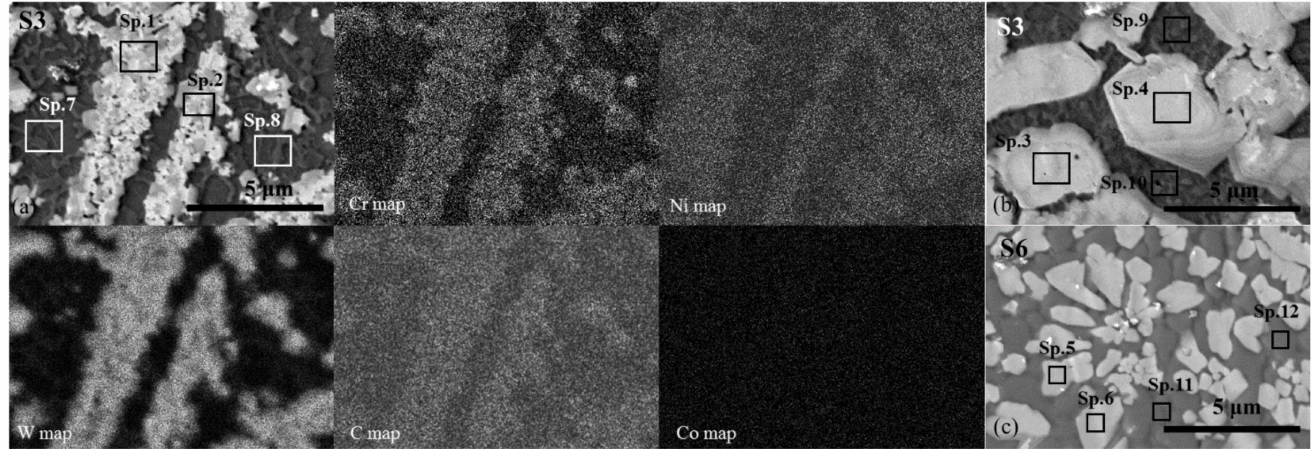
Figure 6. SEM micrographs of the laser-processed coatings S3 ( a , b ) and S6 ( c ) with denoted points of EDS analysis (Sp.1–Sp.12; see Table 2) and maps of the distribution of the elements in the area showed in ( a